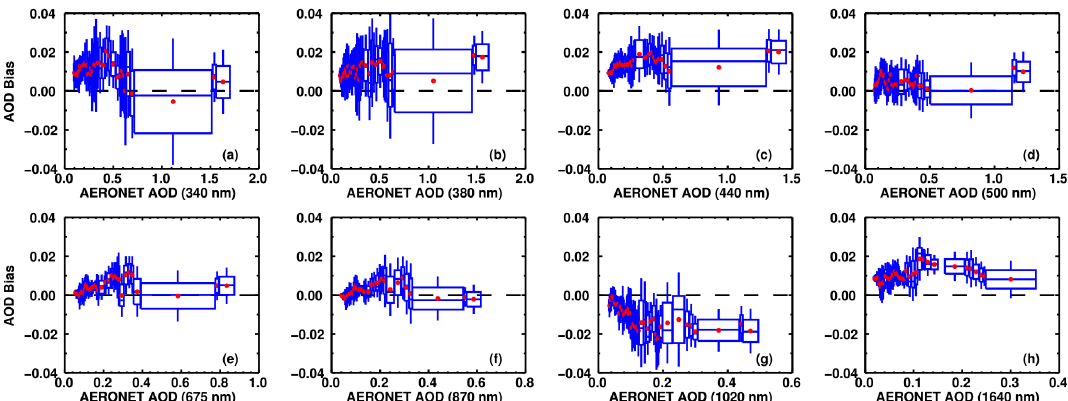
Figure 8. Boxplots of CW193 AOD bias and AERONET AOD using the 25th and 75th percentiles with 20 bins. The dashed black line indicates zero bias. The red dots, middle line, and upper and lower hinges represent the mean and median of the AOD bias and the 25th and 75th percentiles,